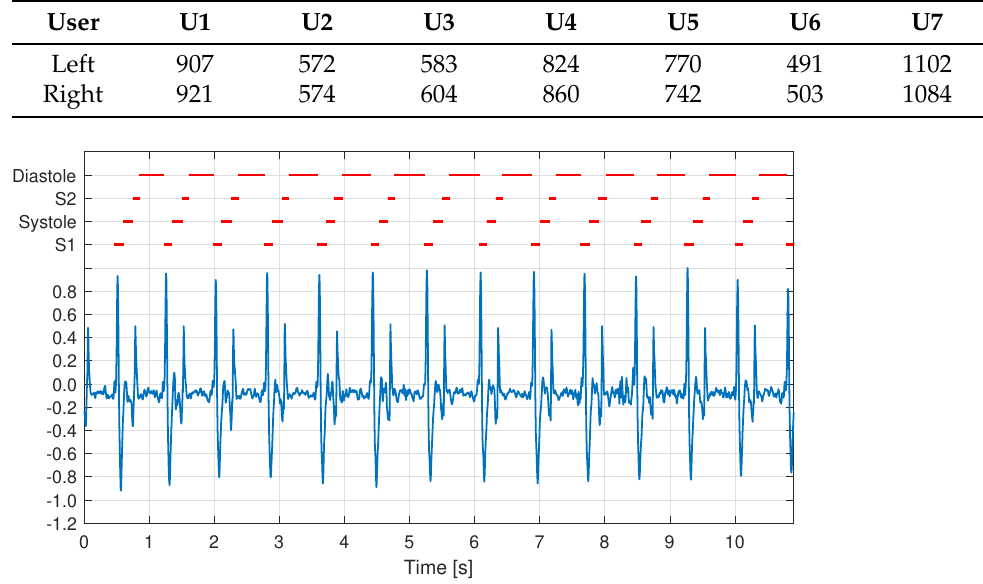
Table 3. Number of segmented cardiac cycles for the left (L) and right (R) carotid artery and for each user.